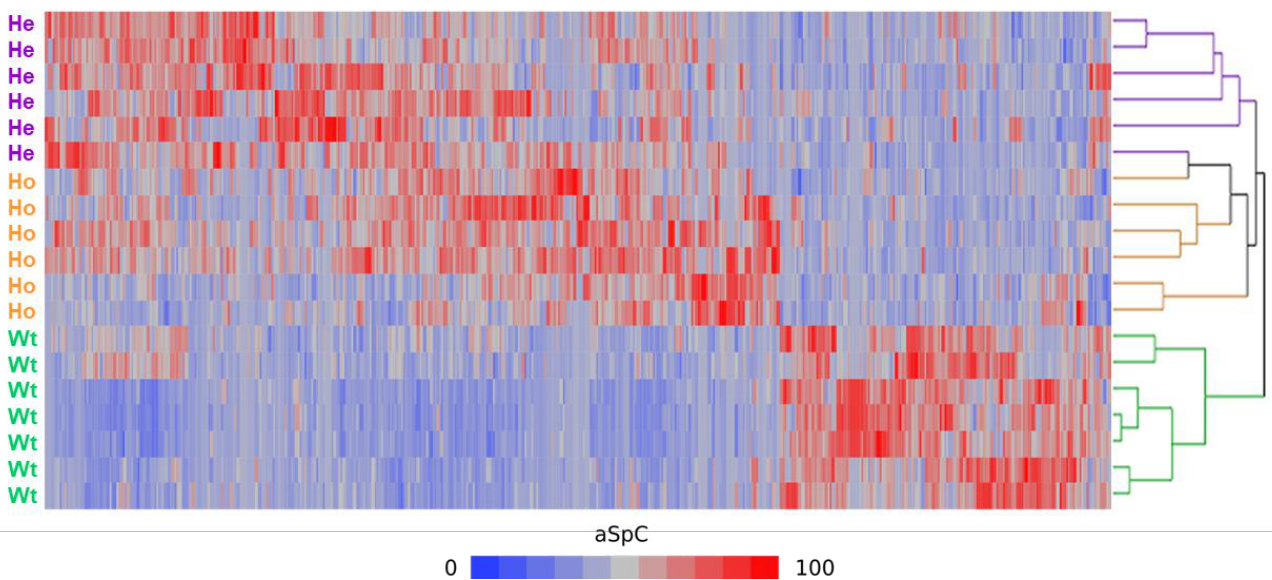
Figure 2. Hierarchical Clustering. Dendrogram of protein lists from 7 Nasu-Hakola subjects and their technical replicates. Clustering was performed by computing the average spectral count (aSpC) value of proteins selected by Linear Discriminant Analysis (LDA); Euclidean’s distance metric and Ward’s methods were applied. Categories were reported in different colours: He subjects in violet, Ho subjects in orange and wt subjects in green.